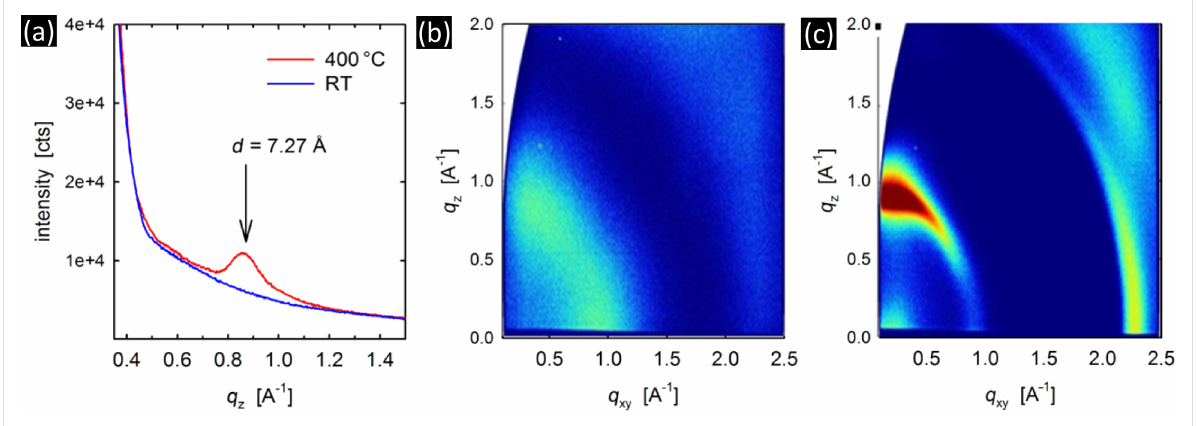
Figure 3: (a) Specular XRD patterns of MoS 2 films ( ≈ 10 nm) deposited at RT and 400 °C. (b,c) GIXD images of MoS 2 films ( ≈ 100 nm) deposited at (b) RT and (c) at 400 °C.